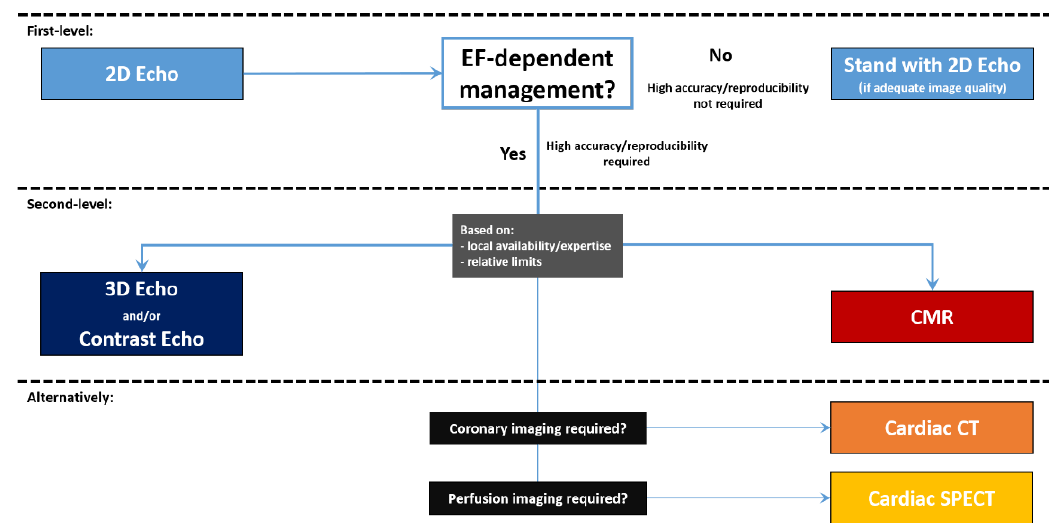
Figure 8. EF evaluation: proposed flow-chart for hierarchical application of clinically available non-invasive imaging modalities. CMR = cardiovascular magnetic resonance, TTE = trans-thoracic echocardiography, SPECT = single photon emission computed tomography, CT = computed tomography.